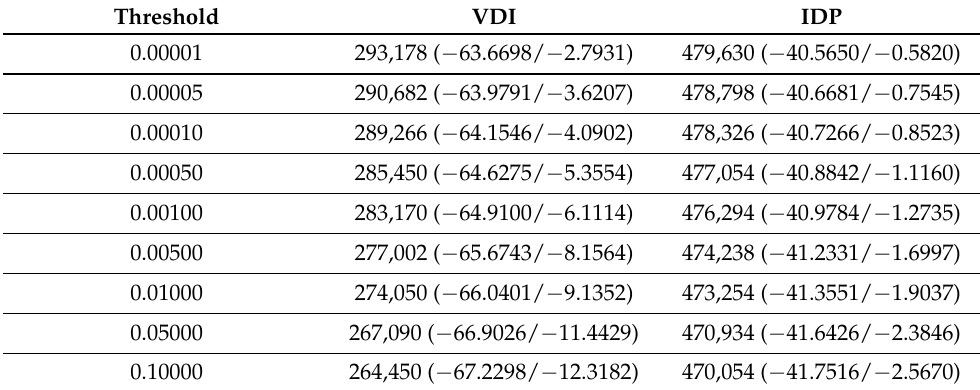
Table 9. pathfinder —Global approximation memory size analysis.